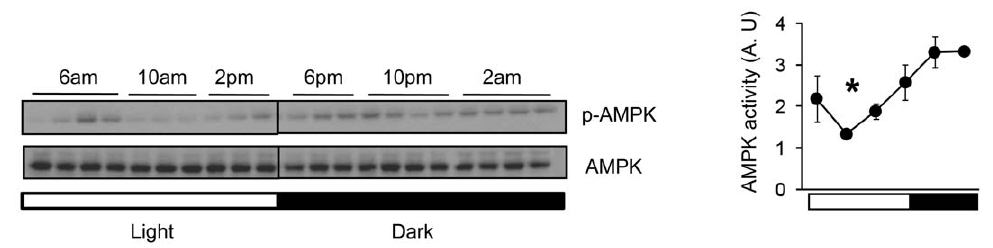
Figure 1. Circadian oscillation of AMPK activity in hypothalamus across the 24 hr light-dark cycle. Left, A representative Western blot showing the phosphorylation level of AMPK (T172) in extracts from mouse hypothalamus which were harvested at 4 hr intervals in a 12h light:12h dark (LD) cycle. The entire hypothalamus from 3 months old male C57BL/6J mice was used for this experiment. Right, Quantification of phosphorylated AMPK a (T172) is shown in arbitrary units (n=3–4 per time point). Average AMPK activity (arbitrary unit) was calculated by densitometric quantification of phosphorylated proteins normalized to total proteins. Lights-on (6am; light) is indicated by a white bar and lights-off (6pm; dark) is indicated by a black bar. Results are means 6 S.E. * P , 0.05 between 10 am and 10 pm.